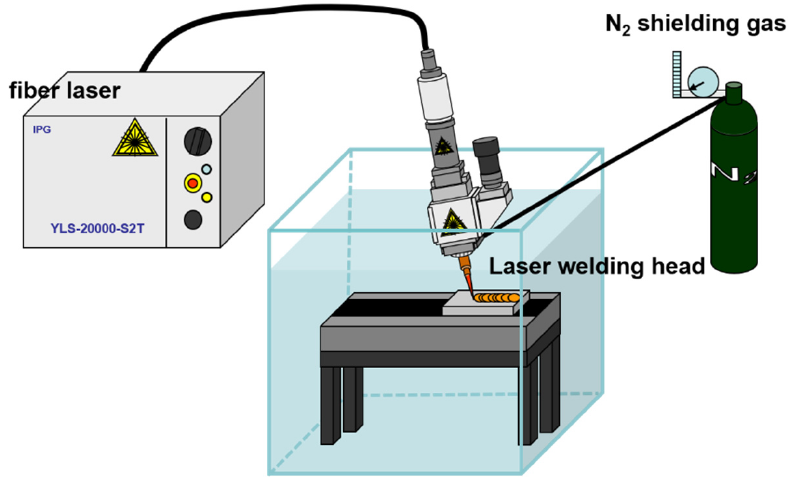
Figure 2. Schematic of local dry underwater laser welding experiment setup. Table 2. Welding parameters. Specimen